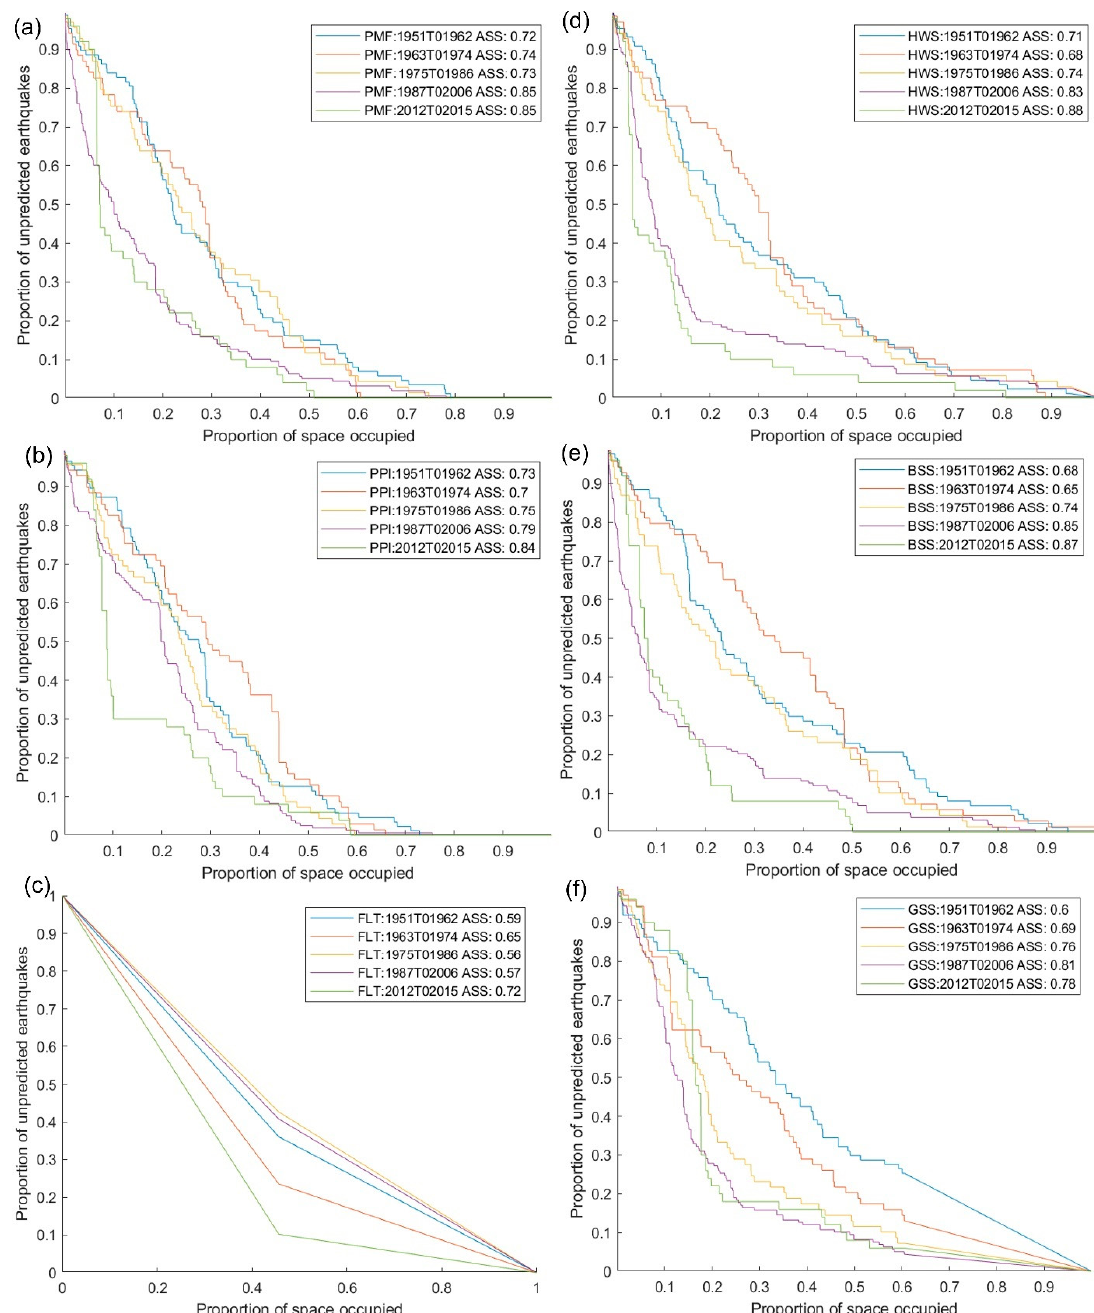
Figure 7. Molchan error diagrams for the covariates during different time intervals. ( a ) HWS; ( b ) PMF; ( c ) BSS; ( d ) PPI; ( e ) GSS; ( f )